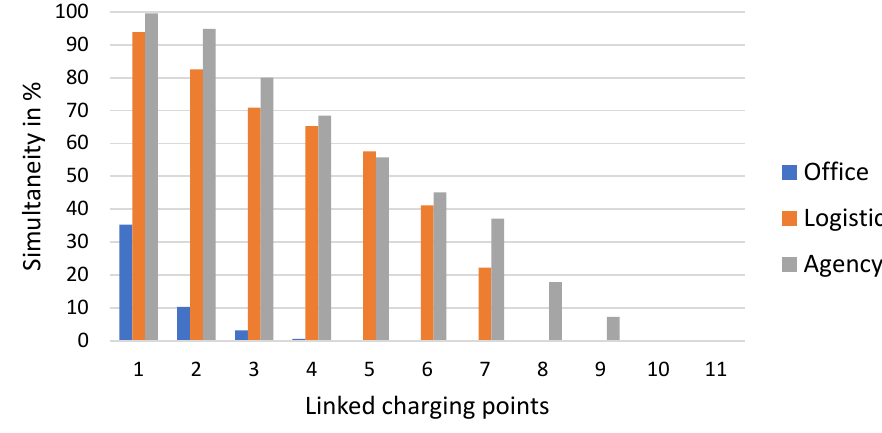
Figure 2. Probability of simultaneously active charging points of the analyzed